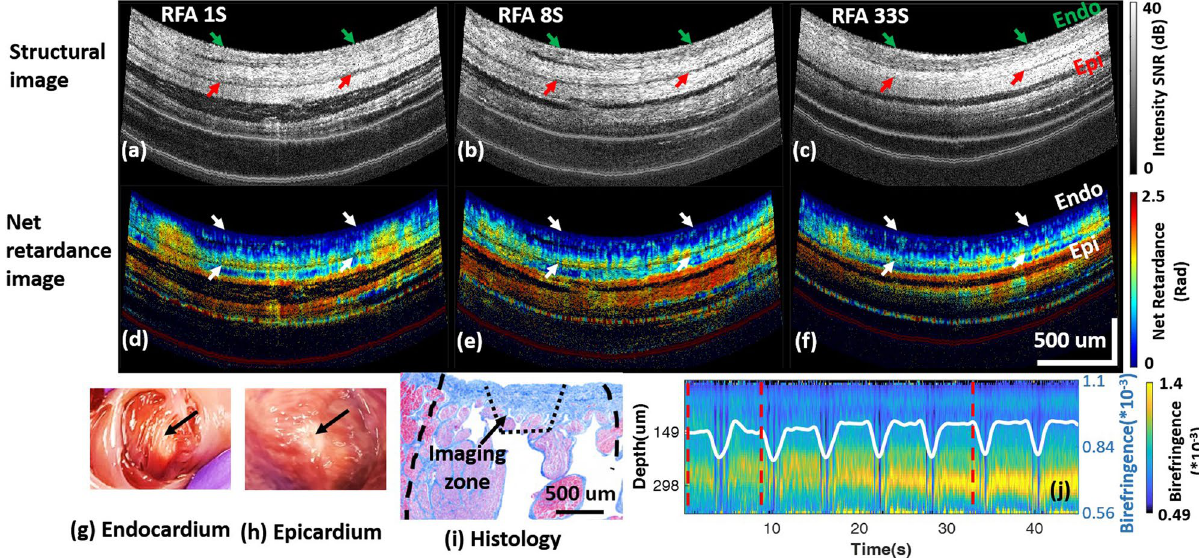
Figure 7. A false negative lesion at LAA. ( a – c ) and ( d – f ) are the structure images and net retardance images of the lesion at 1 s, 8 s, and 33 s of ablation, respectively; ( g , f ) are photos of the TTC stained lesion on the endocardium and epicardium; ( i ) histology of lesion section with trichrome staining; ( j ) shows the cross-A-line averaged tissue birefringence change and the averaged tissue birefringence